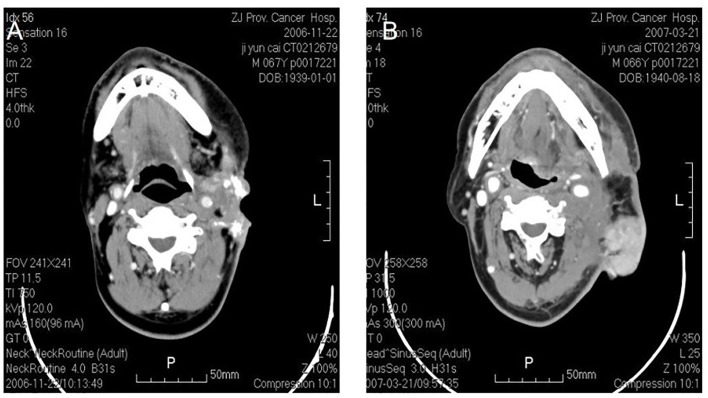
Osteosarcoma in left neck. CT shows an irregular soft tissue imaging in the left neck, with heterogeneited density, several schistose calcification in it. CT also shows that the lesion has been heterogeneited enhanced after contrast, with obscure margin to the left cervical vascular, with superficial elcosis. (A) The lesion recurred after 4 months. (B) The picture on the right shows pedicled pectoralis major myocutaneous flap with surrounded recurrent lesions.